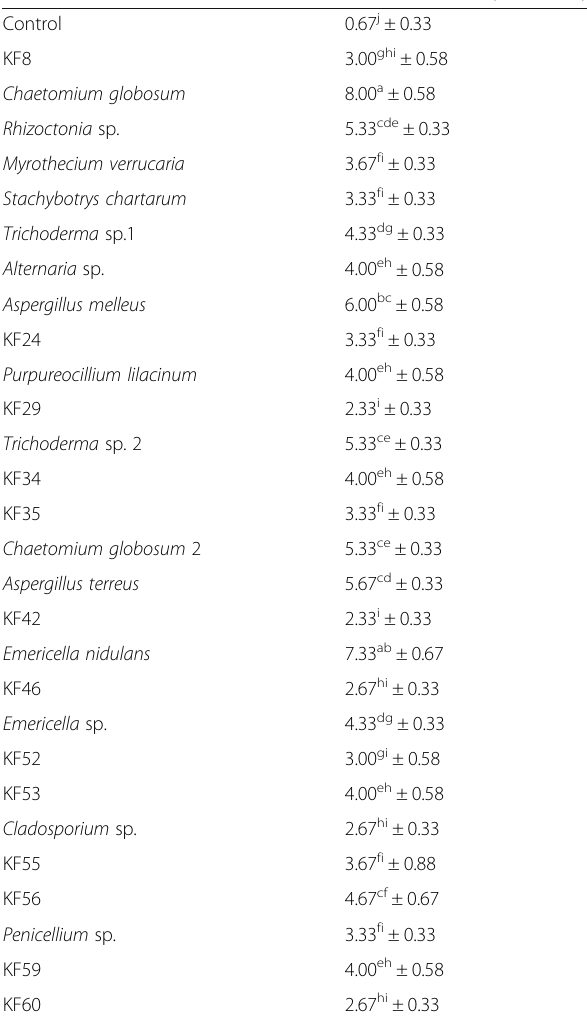
Table 1 Effect of culture filtrate of potent isolates on the females of Tetranychus urticae Isolate